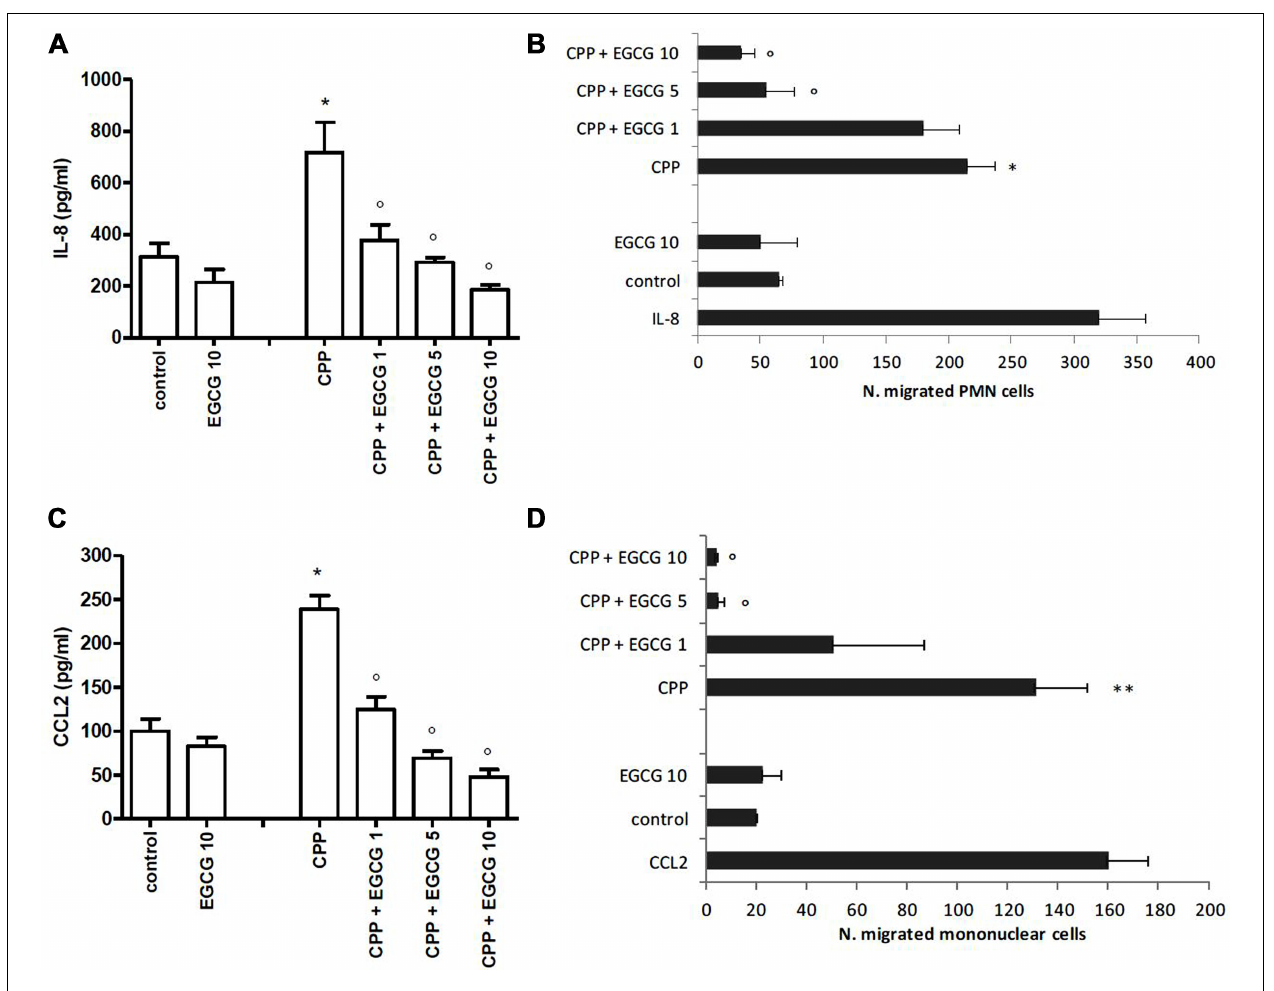
FIGURE 1 | Effect of EGCG on IL-8 and CCL2 production by FLS stimulated with CPP crystals (A,B). Effect of culture supernatants on the migration of PMN and mononuclear cells (C,D) .The values are expressed as